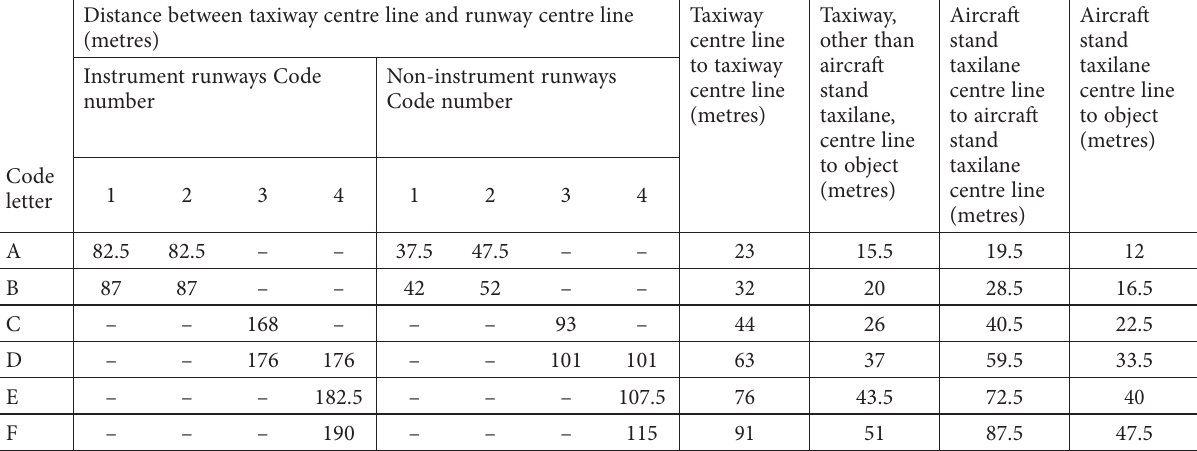
Table 1. Parameters to calculate the runwaysurfaces of Table 3–1 from Annex 14 (ICAO, 2016) Distance between taxiway centre line and runway centre line